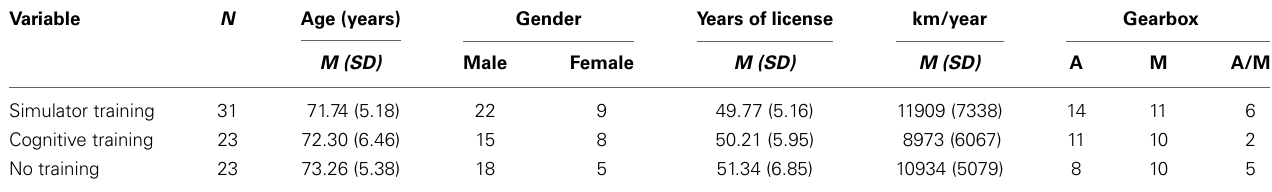
Table 1 | Demographic